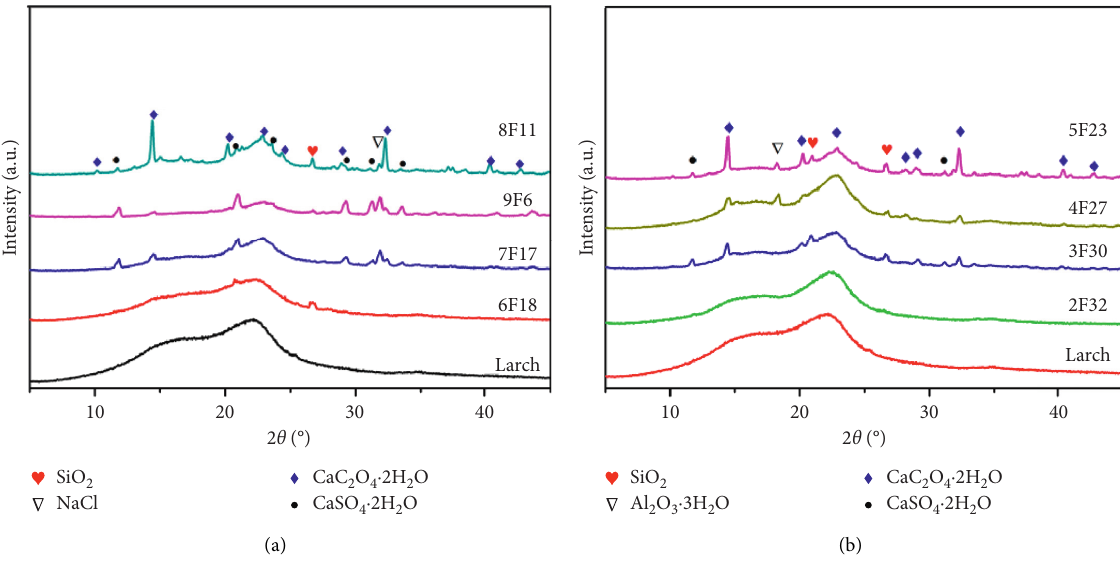
Figure 3: (a) XRD patterns of the aged samples 9F6, 8F11, 7F17, and 6F18 and of the sound sample. Identified phases: SiO CaSO 4 · 2H 2 O, and CaC 2 O 4 · 2H 2 O. (b) XRD patterns of the aged samples 5F23, 4F27, 3F30, and 2F32 and of the sound sample. Identified phases: SiO 2 , Al 2 O 3 · 3H 2 O, CaSO 4 · 2H 2 O, and CaC 2 O 4 · 2H 2